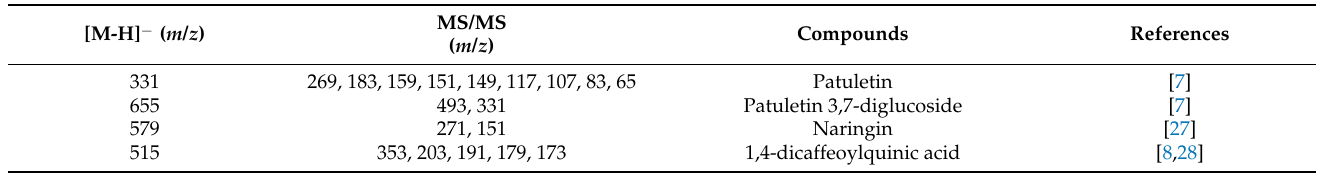
Table 5. Mass spectral characteristics and the identity of the compounds in the TFE